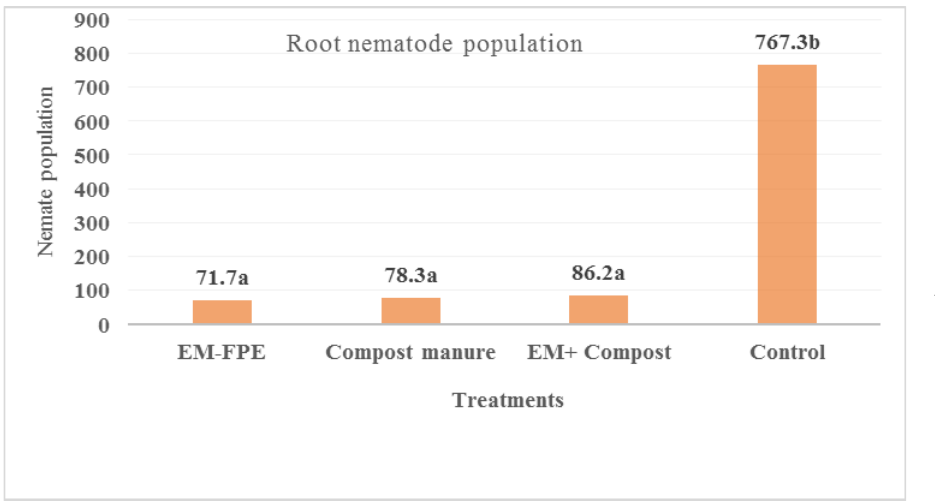
Fig. 1 Effect of treat- ments on the